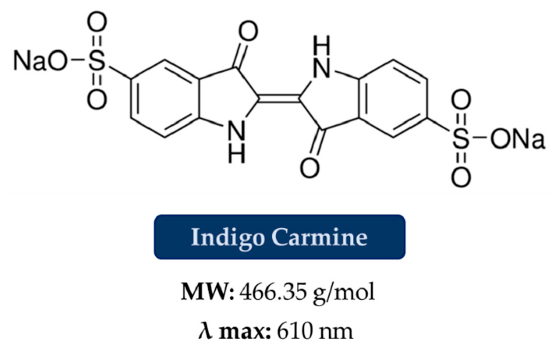
Figure 6. Chemical and sorption properties of Indigo Carmine.